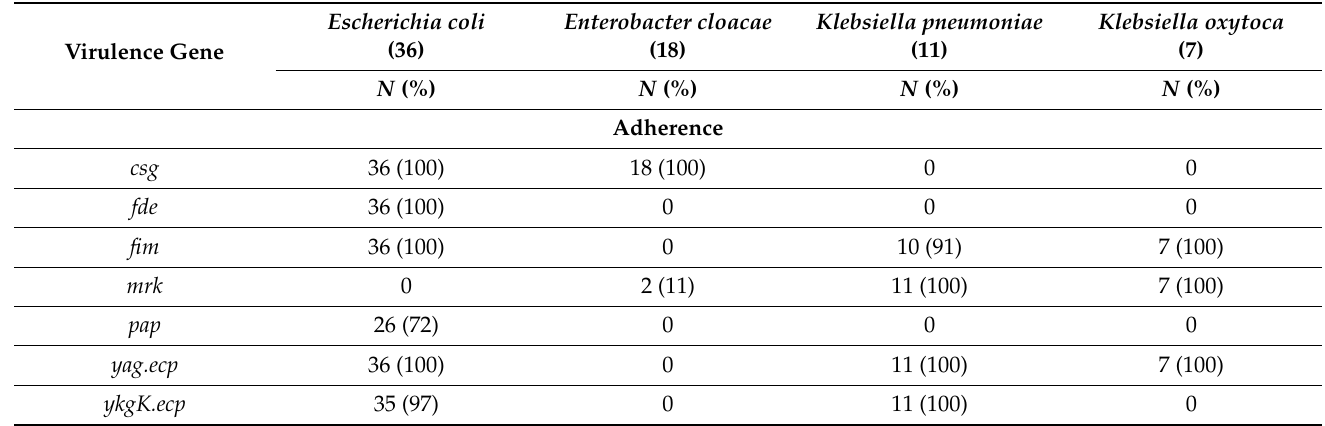
Table 4. Median number of classes of virulence genes carried per bacterial strain.